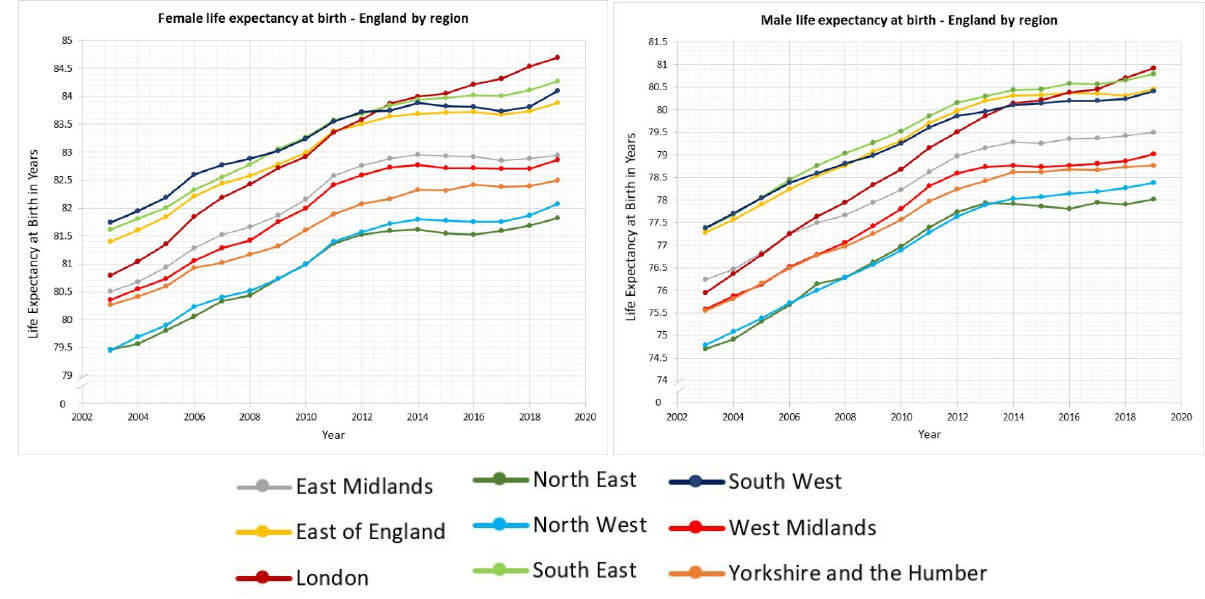
Figure 3. Life expectancy by region for England 2002–2019. Note: Life expectancies represent the average for the preceding two years.